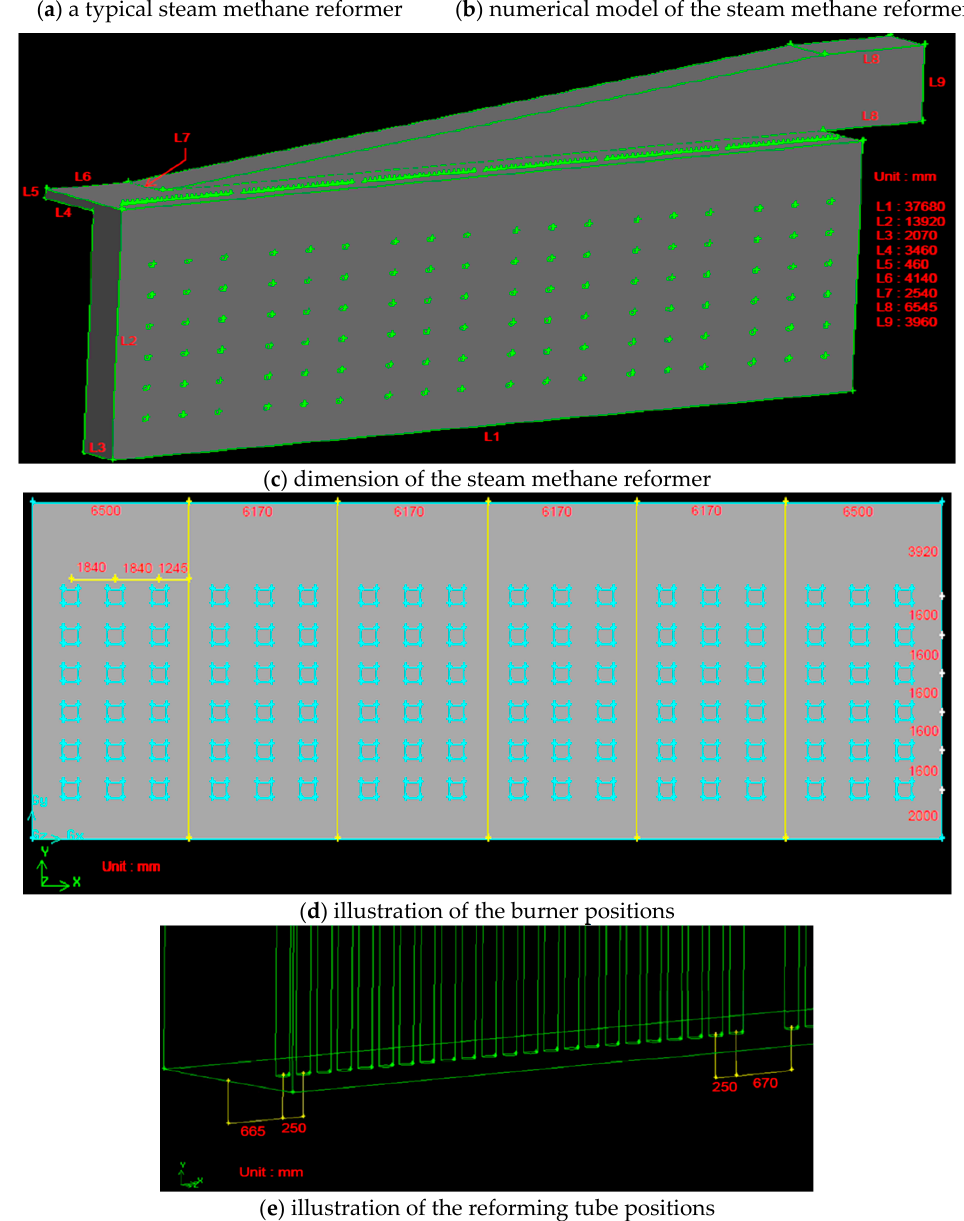
Figure 1. Configuration and dimension of the steam methane reformer investigated.